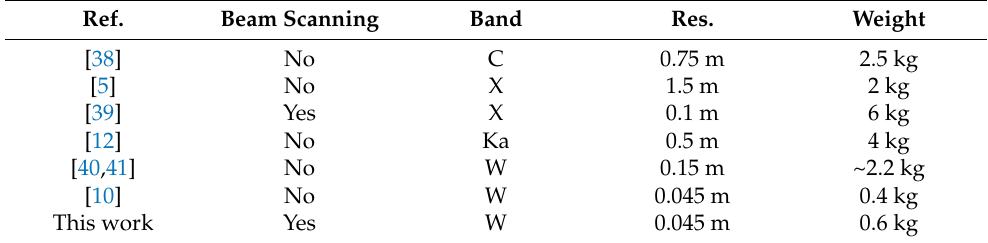
Table 3. Key technical specifications of typical UAV mini-SAR.